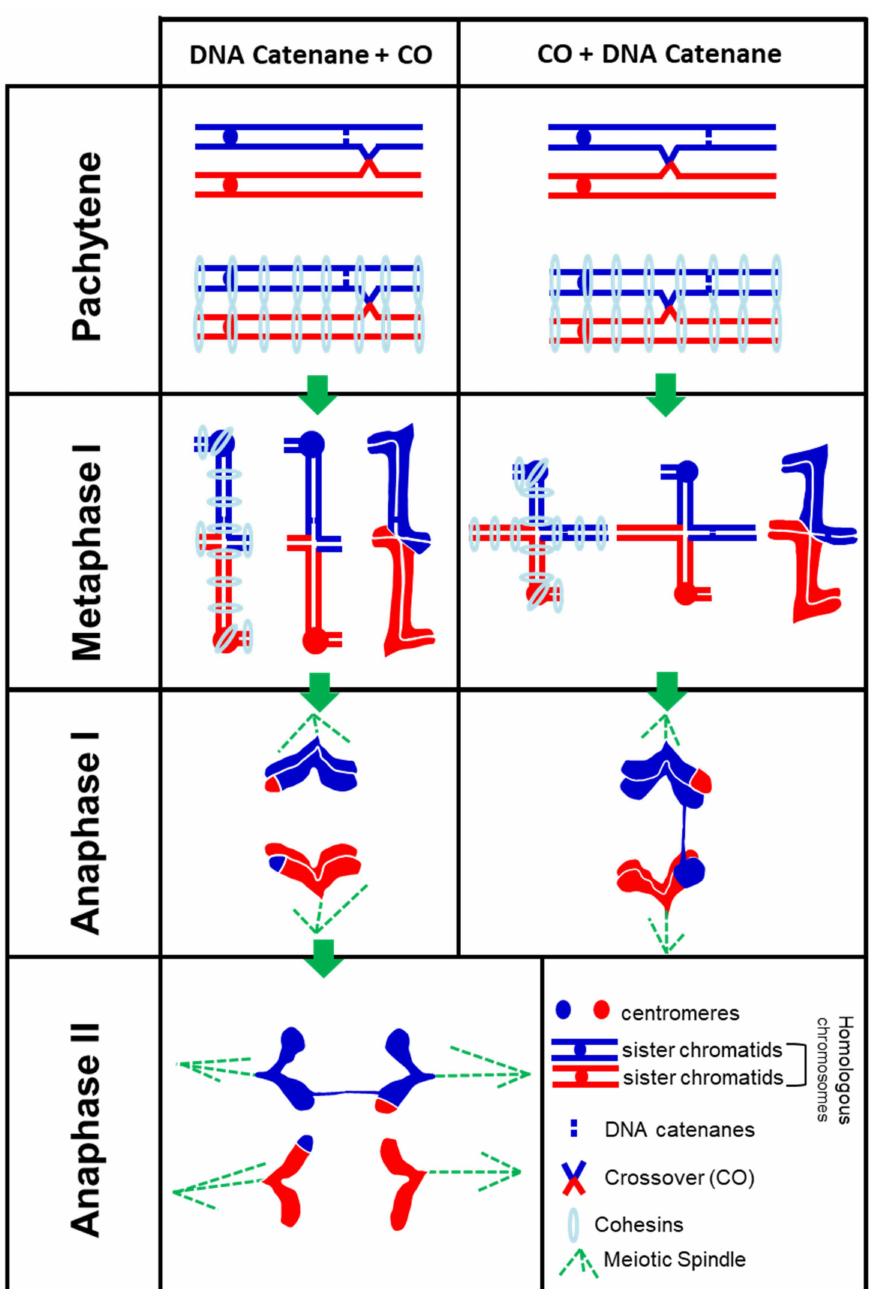
Figure 4. Diagram showing how different localization of a DNA replication catenane and a single crossover (CO) along a chromosome arm could facilitate anaphase bridges at both anaphase I and anaphase II. (Left) A catenane has occurred between the centromere and a CO, producing an anaphase bridge at anaphase II. (Right) A CO has occurred between the centromere and a catenane, producing an anaphase bridge at anaphase